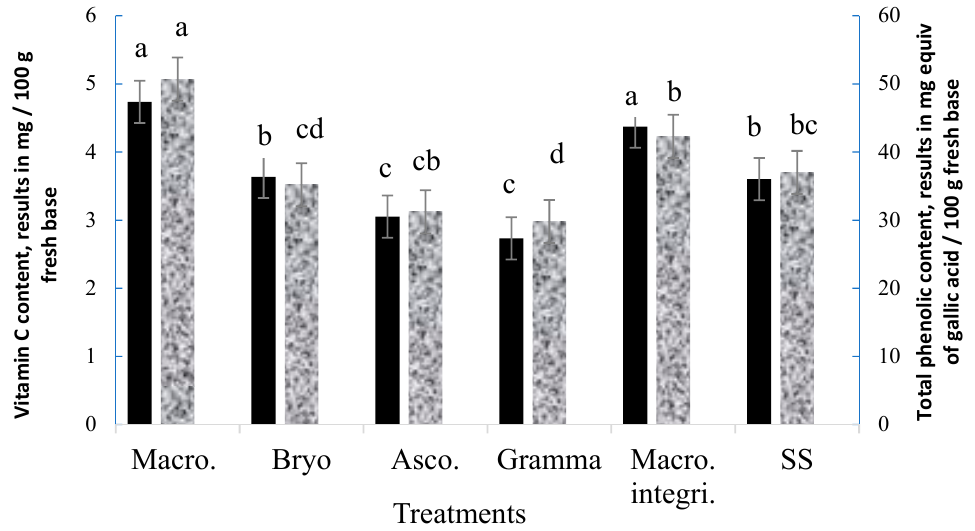
Figure 2. Total phenolic (black bars) and vitamin C content (grey bars) of cucumber produced in shade mesh with the application of different nutrient solutions derived from algae. Means followed by the same letter are not significantly different between treatments (Tukey; p ≤ 0.05). Macro. = Macrocystis pyrifera , Bryo = Bryothamnion triquetrum , Asco. = Ascophyllum nodosum , Gramma = Grammatophora spp., Macro. integri = Macrocystis integrifolia , SS = Steiner solution.